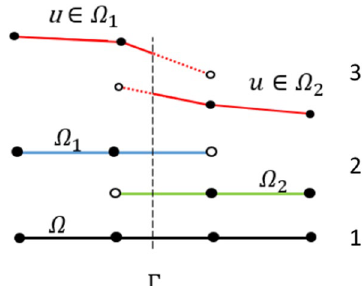
Fig. 1 (1) Original finite element mesh crossed by an interface, (2) Two overlapping finite element meshes with introduced ghost nodes (open circles), (3) Numerical solution where solid line indicates solution